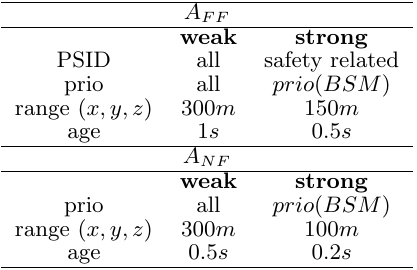
Table 1: Acceptance Policy